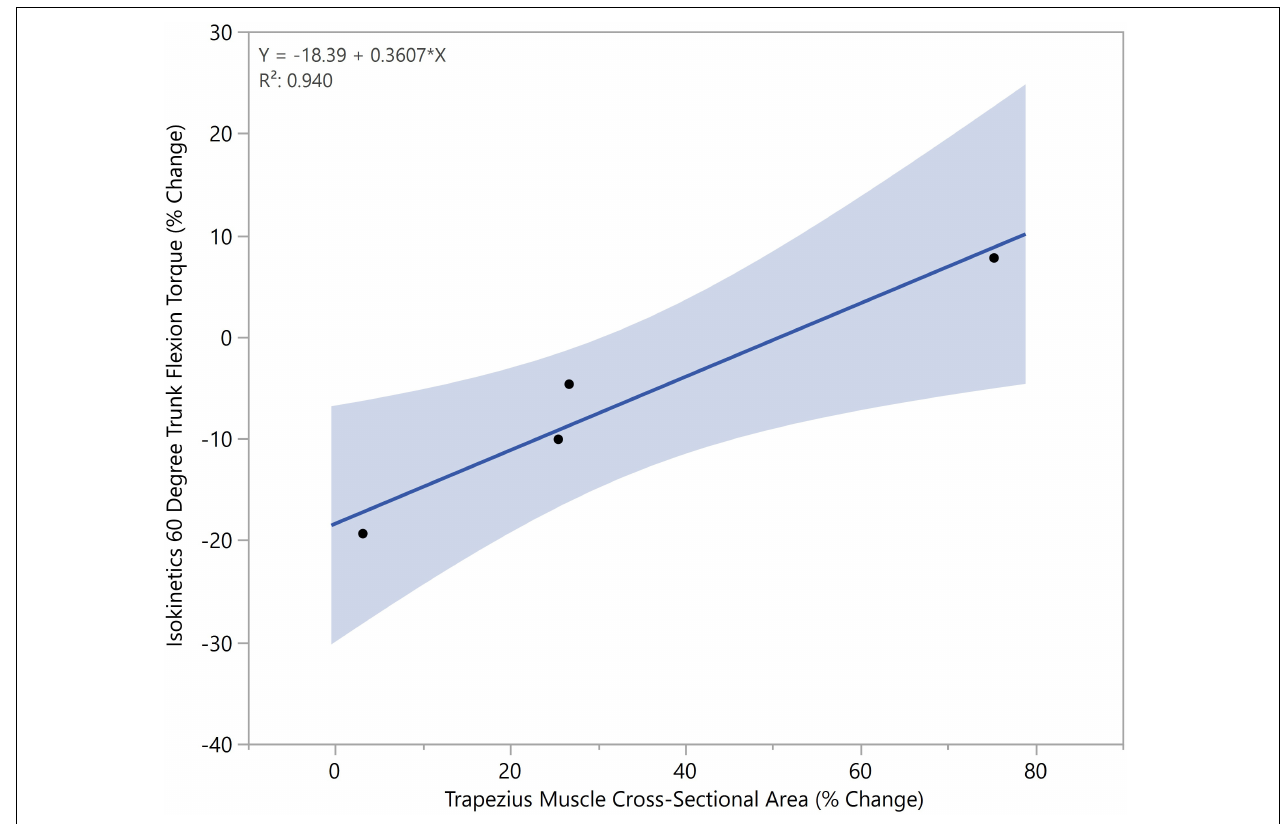
FIGURE 7 | Increased trapezius cross-sectional areas correlated with increased preservation of truncal strength ( p <